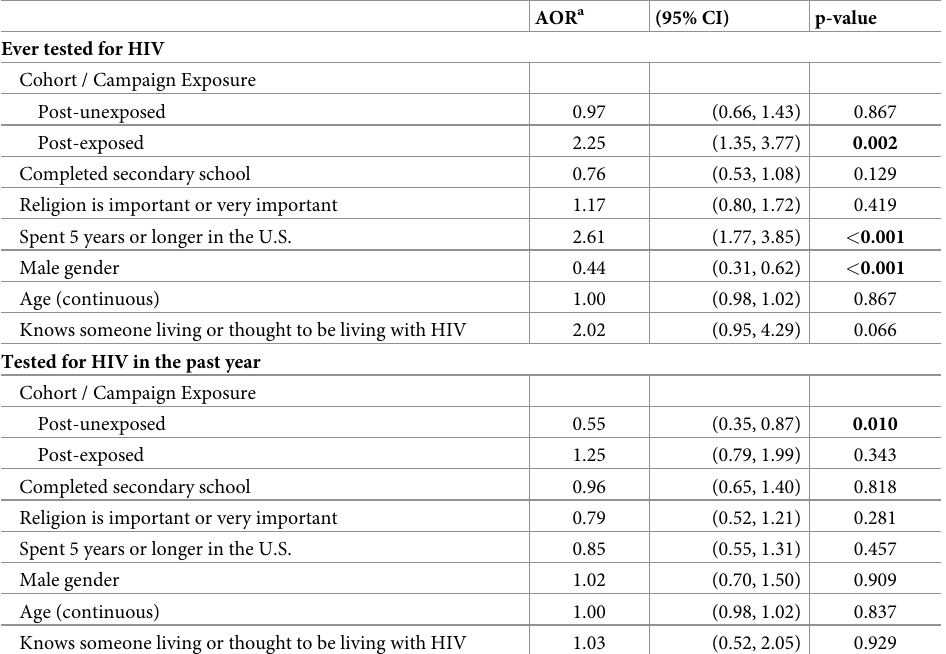
AOR a (95% CI) p-value